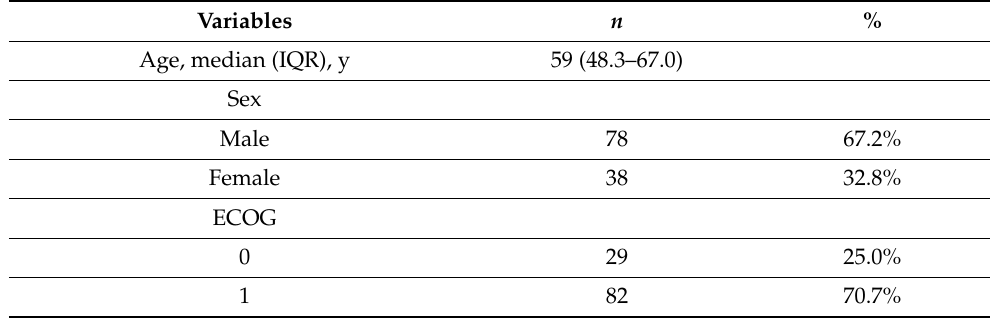
Table 1. Patient and treatment